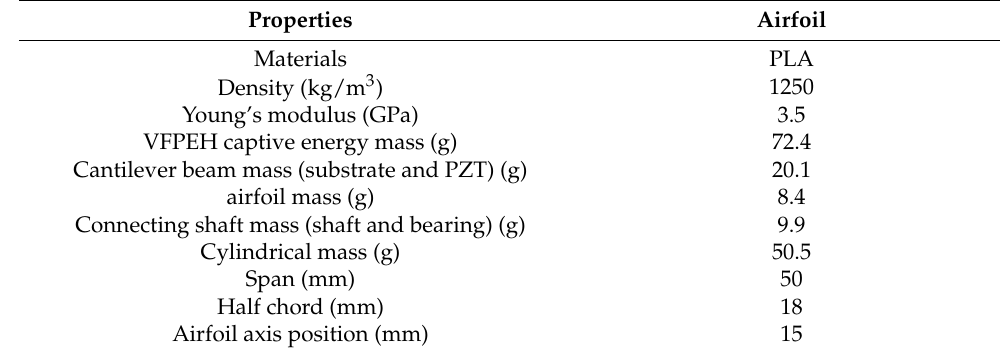
Table 2. NACA0012 wing dimensional